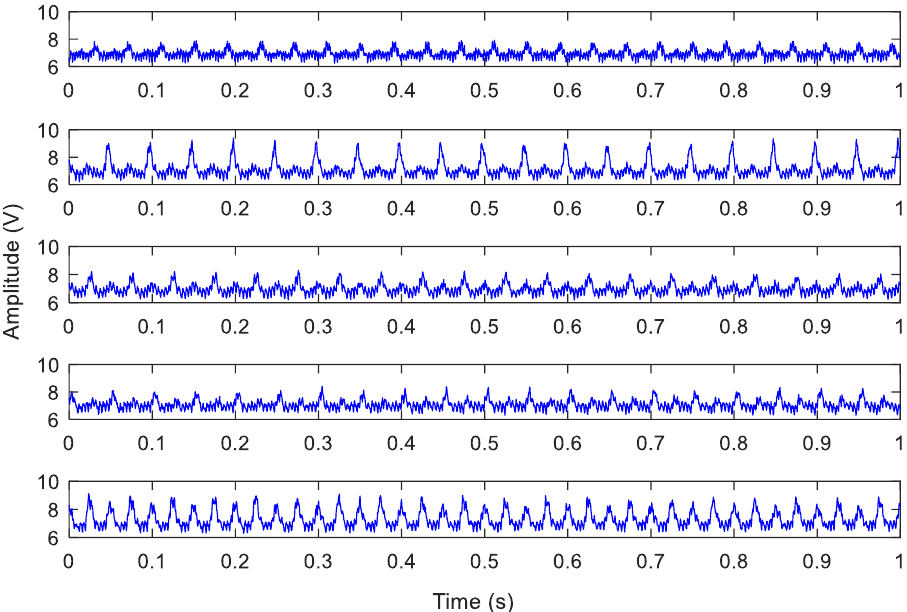
Figure 6. Current signals of the five different tool wear states.